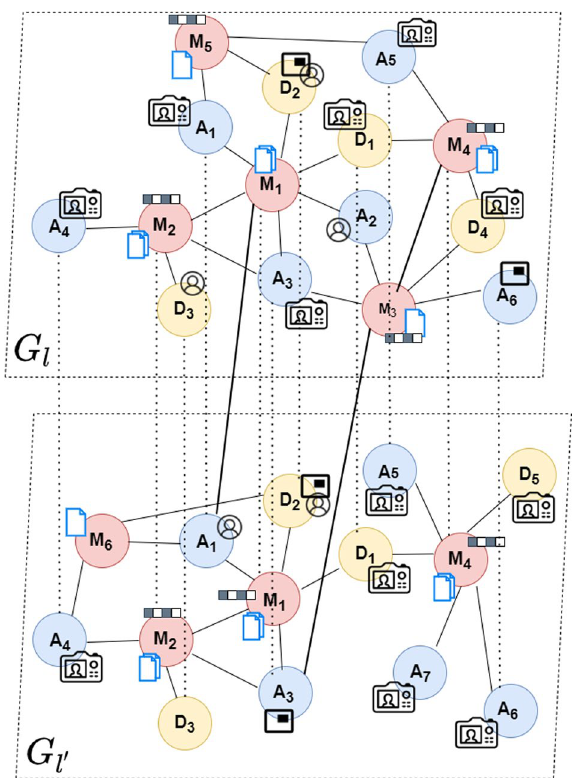
Fig. 1 Illustration of a multilayer heterogeneous attributed graph with two layers ( G l and G l ′ ), three types of nodes (M ( movie )–A ( actor )–D ( director )), and different content features for different nodes (e.g., text, images, structured